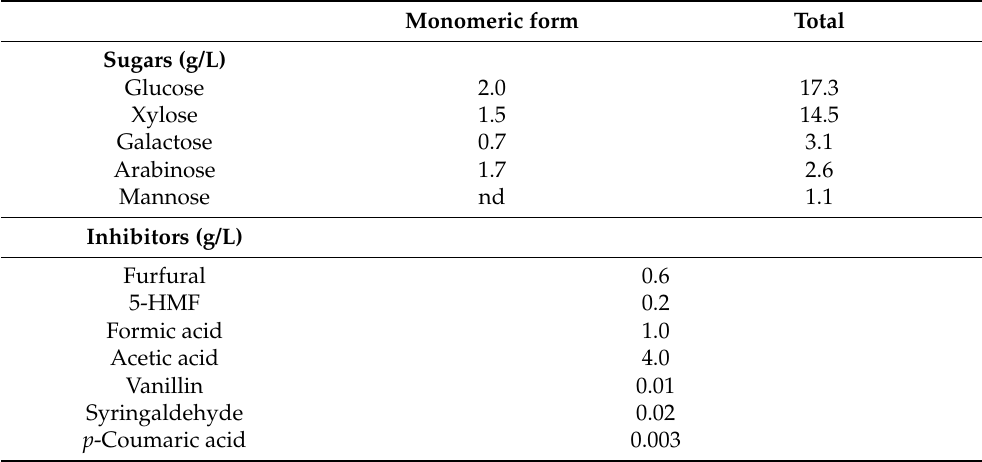
Table 1. Composition of liquid fraction after steam explosion